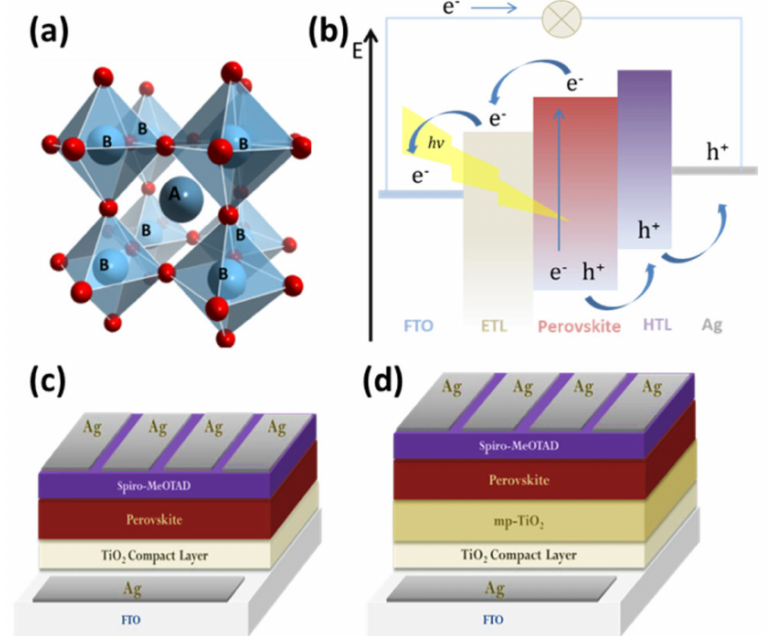
Figure 2. ( a ) Illustration of the general perovskite crystal structure, ( b ) the working mechanism of a PSC, and ( c , d ) the two typical device architectures; planar and mesoporous, respectively. Reproduced with permission from [73], Copyright 2019,